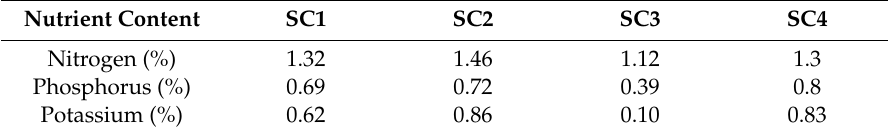
Table 2. Chemical composition of the four substrates used for growing the sage plants.